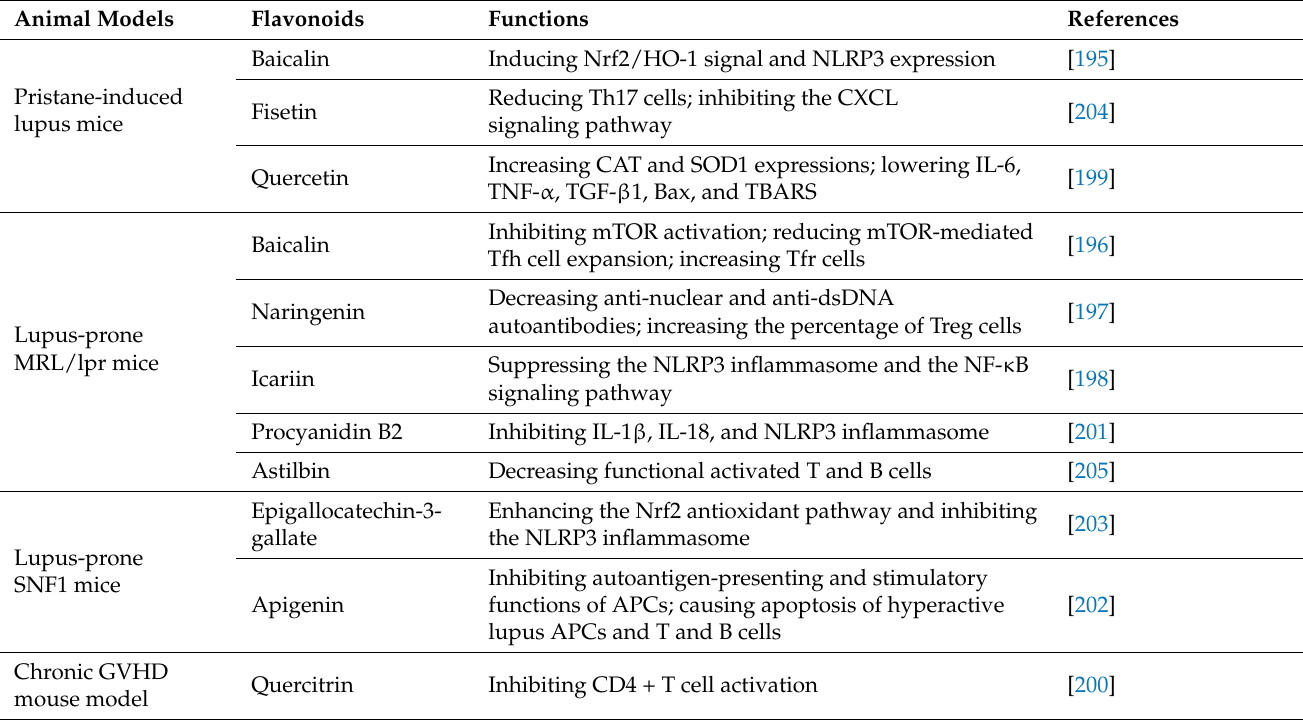
Table 5. Flavonoids in lupus